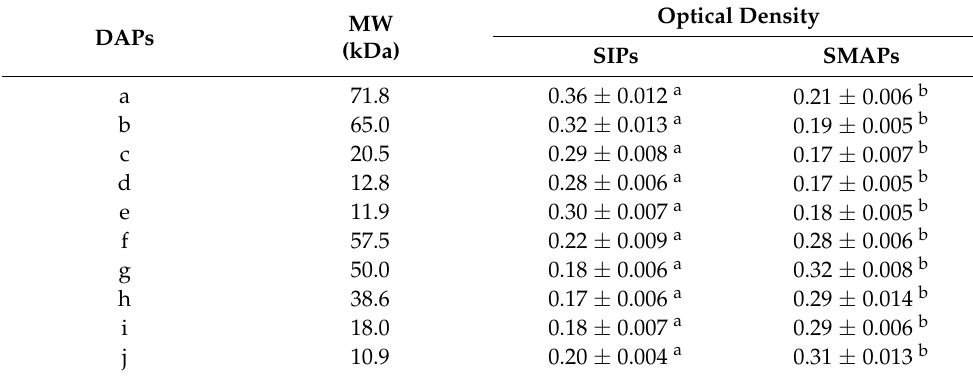
Table 1. Average optical density (OD) values (mean ± SE) of differentially abundant proteins (DAPs) of the sperm intracellular proteins (SIPs) and the sperm membrane-associated proteins (SMAPs) of dog ( Canis lupus familiaris ) cauda epididymal spermatozoa (n = 15). Different superscripts within rows indicate statistically significant differences ( p ≤ 0.001) between fractions. DAPs were marked with letters from a to j. MW—average molecular